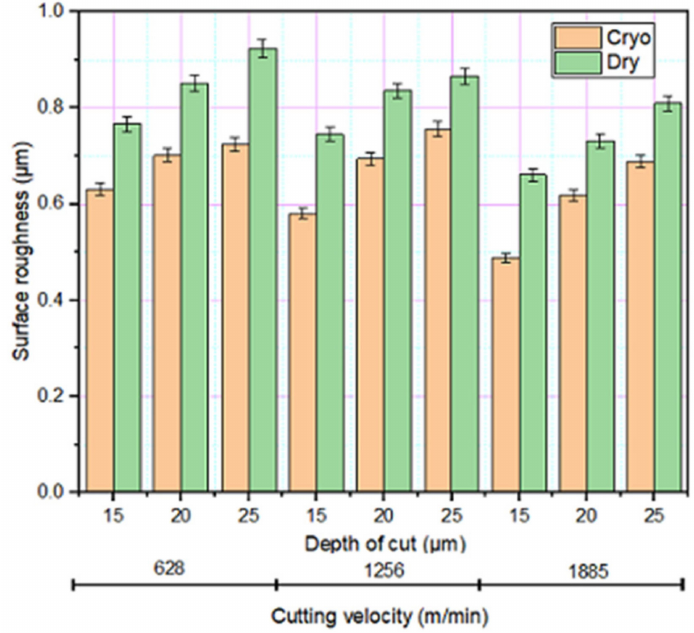
Figure 5. Variation in surface roughness under different grinding